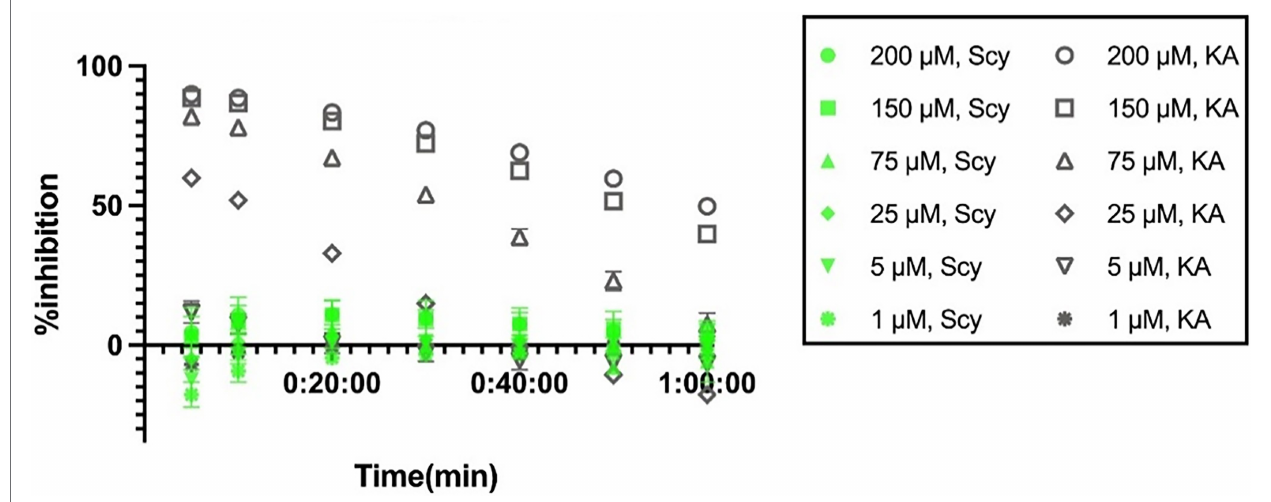
FIGURE 9 | Dose-dependent percent inhibition of mushroom tyrosinase by scytonemin ( 2 ) and kojic acid ( 3 ) over time. Shown in green are the results of scytonemin and in gray are the results of the positive control kojic acid (KA). Experiments were carried in triplicate and error bars represent standard